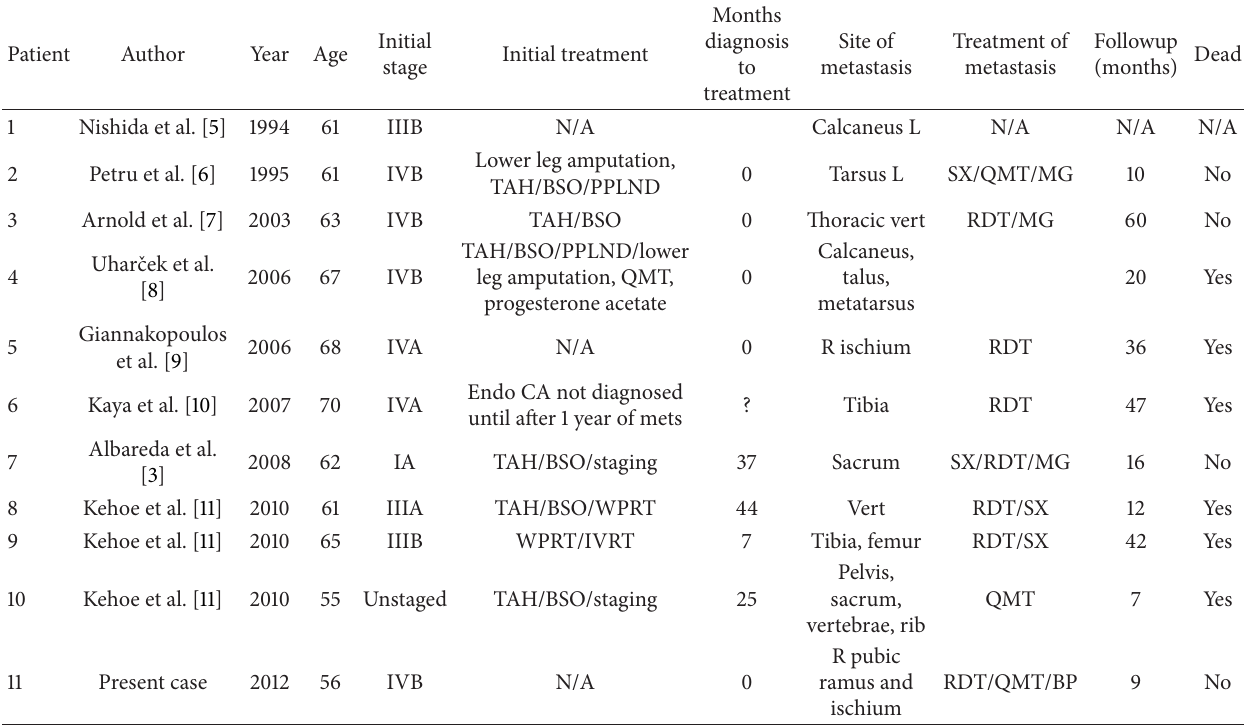
Table 1: Bone metastasis in patients with grade 1 endometrial cancer.